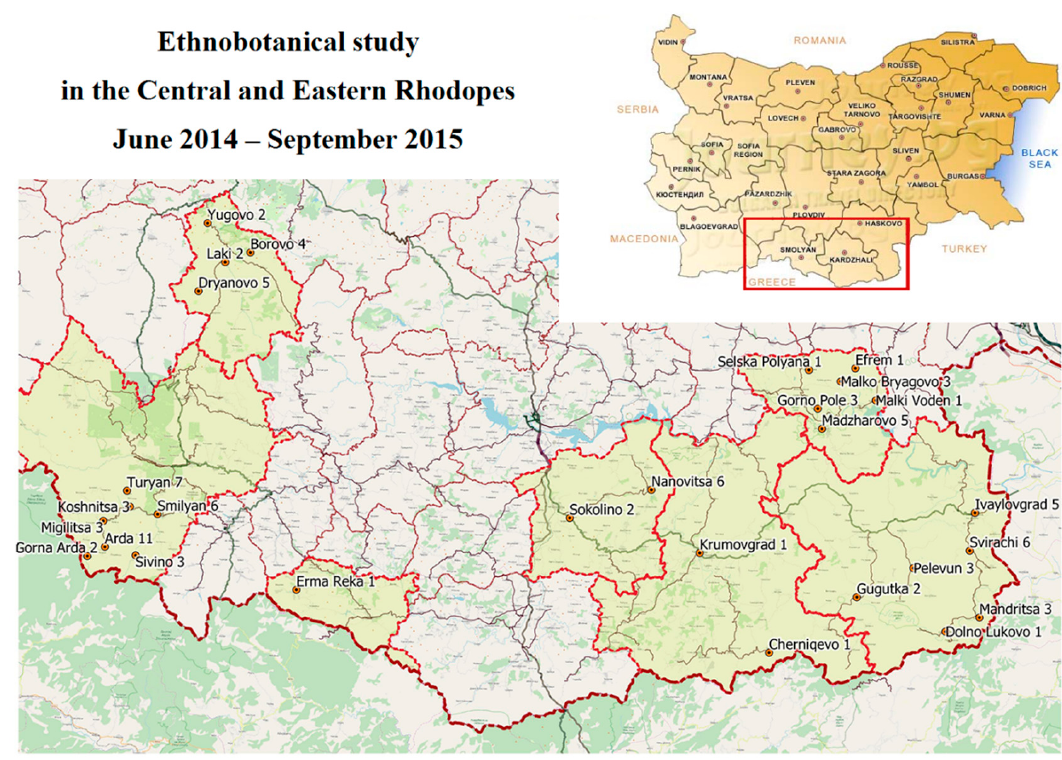
Figure 1. Se tt lements of the survey in the Rhodope Mountain and the number of informants. Figure 1. Settlements of the survey in the Rhodope Mountain and the number of